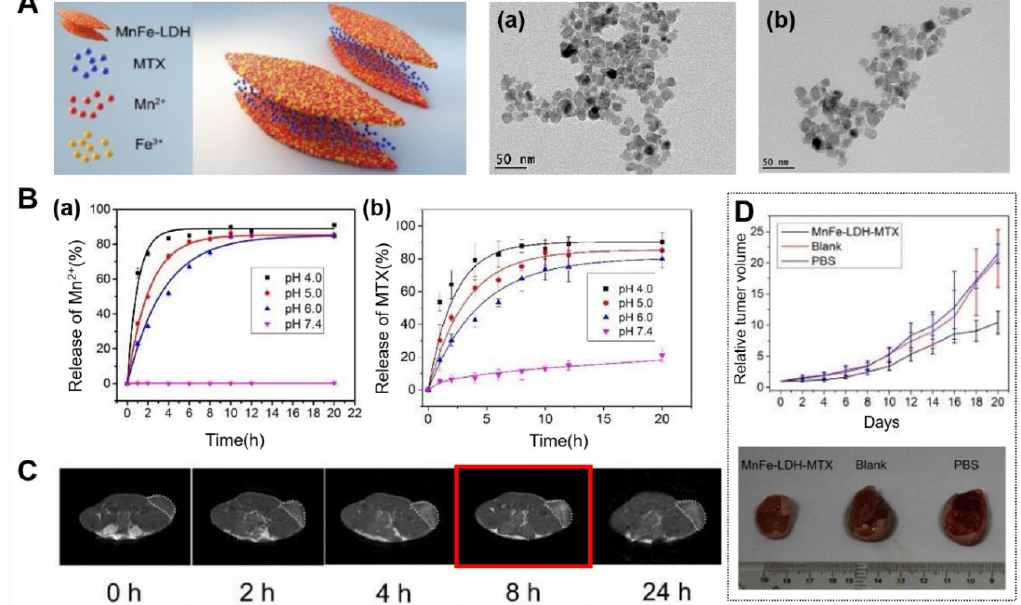
Figure 7. ( A ) Schematic illustration of MnFe-LDH-MTX, TEM images of MnFe-LDH ( a ) and MnFe-LDH-MTX ( b ), ( B ) release profiles of Mn ions from MnFe-LDH ( a ) and MTX from MnFe-LDH-MTX ( b ) in different pH buffers (n = 3), ( C ) in vivo T 1 -weighted MR images of S180 tumor bearing BALB/c nude mice after the administration of MnFe-LDH-MTX within 24 h, ( D ) tumor volume change of S180 tumor bearing mice during treatment and photo images of excised tumors collected at 20 days after treatment, reproduced from [11], with permission from the Royal Society of Chemistry, 2017.